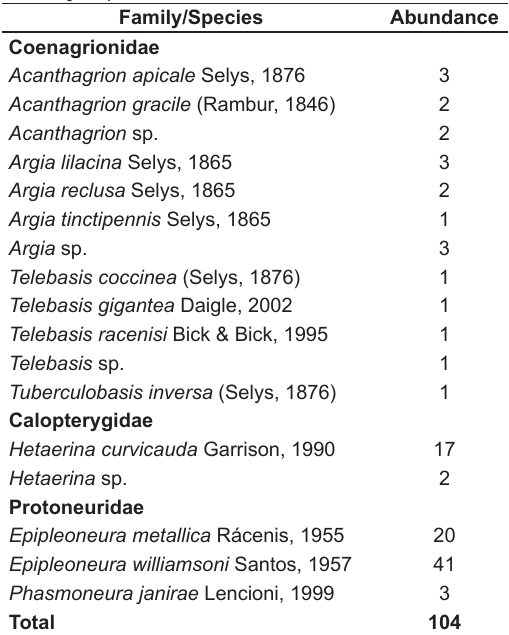
Table 1. Abundances of damselflies species in the nine transects of three streams in southern Amazon, Querência municipality, Mato Grosso State,